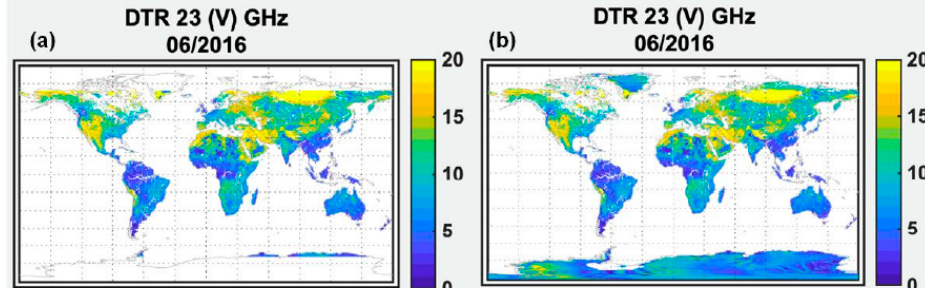
Figure 10. Global DTR (K) map ( a ) from initial GMI TB values, and ( b ) expanded to the polar region from GMI final interpolated TB values for June 2016 at 23 GHz vertical